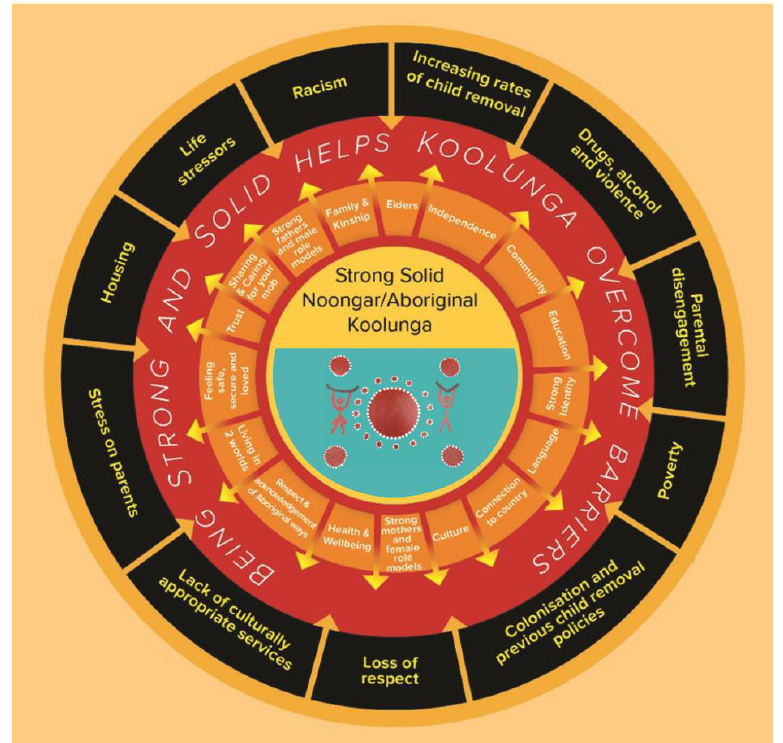
Figure 2. Things that get in the way of raising strong, solid Koolunga (Reprinted with permission from the Ngulluk Koolunga Ngulluk Koort project, Telethon Kids Institute).